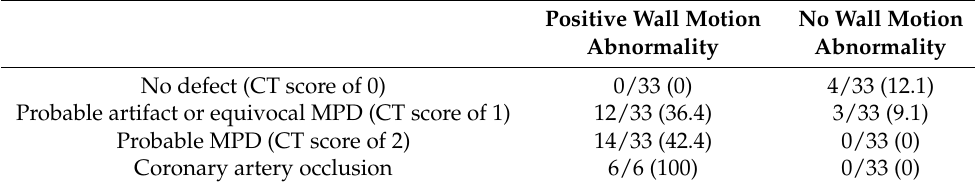
Table 4. Association between wall motion abnormality on echocardiography and myocardial perfu- sion defect (MPD) on non-gated enhanced chest CT in group 1. Positive Wall Motion No Wall Motion Abnormality Abnormality No defect (CT score of 0) 0/33 (0) 4/33 (12.1) Probable artifact or equivocal MPD (CT score of 1) 12/33 (36.4) 3/33 (9.1) Probable MPD (CT score of 2) 14/33 (42.4) 0/33 (0) Coronary artery occlusion 6/6 (100) 0/33 (0)